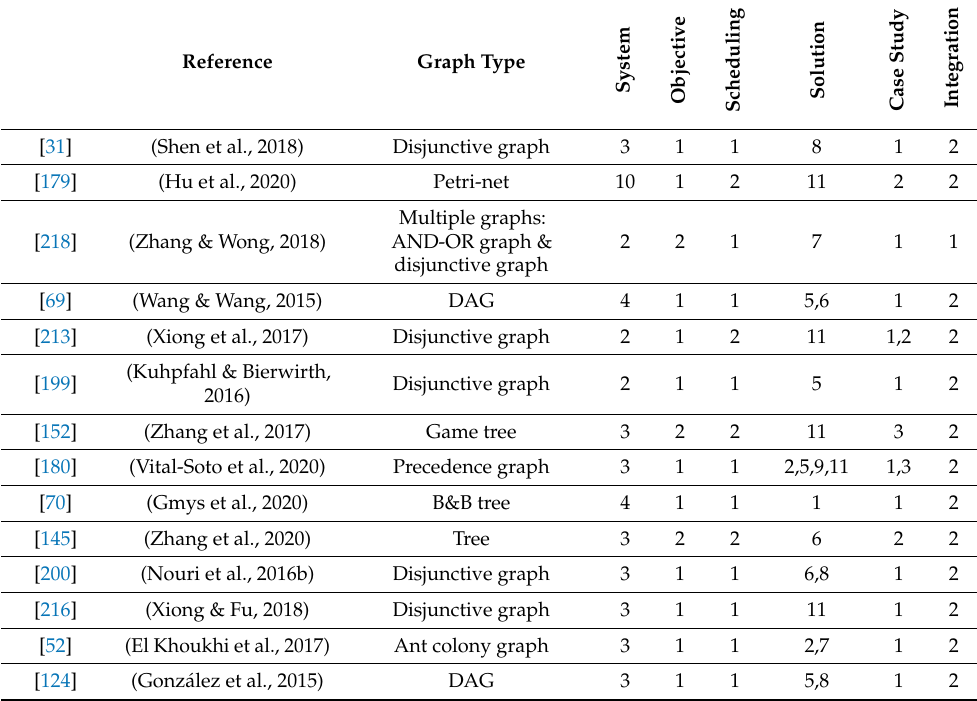
Table 10. Properties of the problems in the top 10% most cited